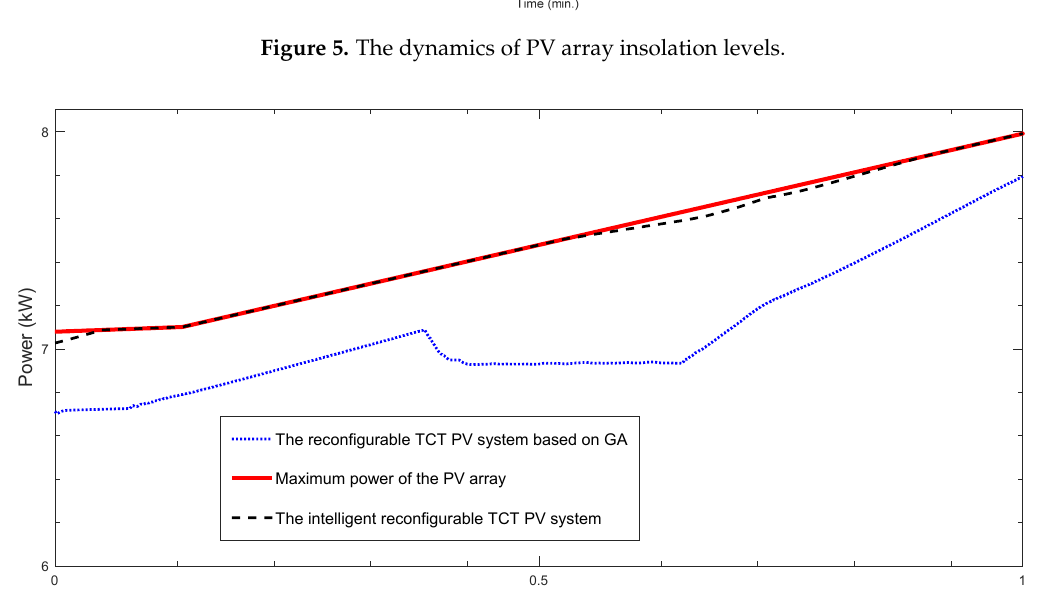
Figure 6. Plot of the PV array power provided by the intelligent reconfigurable PV system and the reconfigurable TCT PV system based on GA.